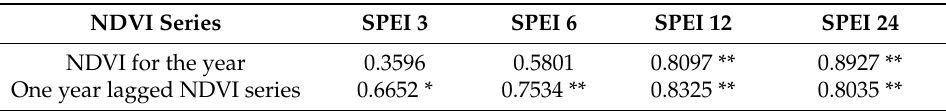
Table 2. The correlation of annual maximum NDVI and SPEI at multi-time scales. NDVI Series